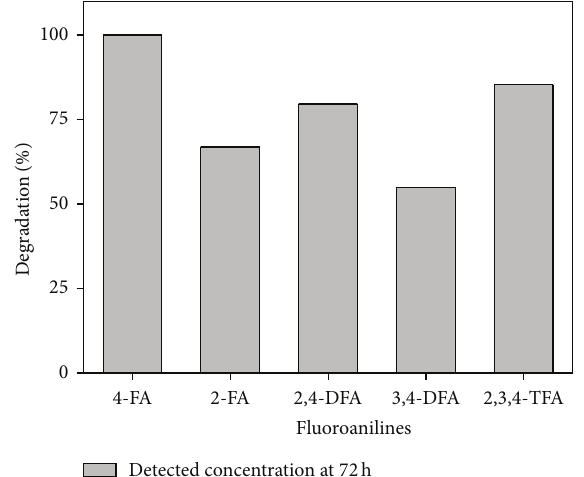
Figure 7: Fluoroanilines (200 mg/L) degradation by resting cells of strain